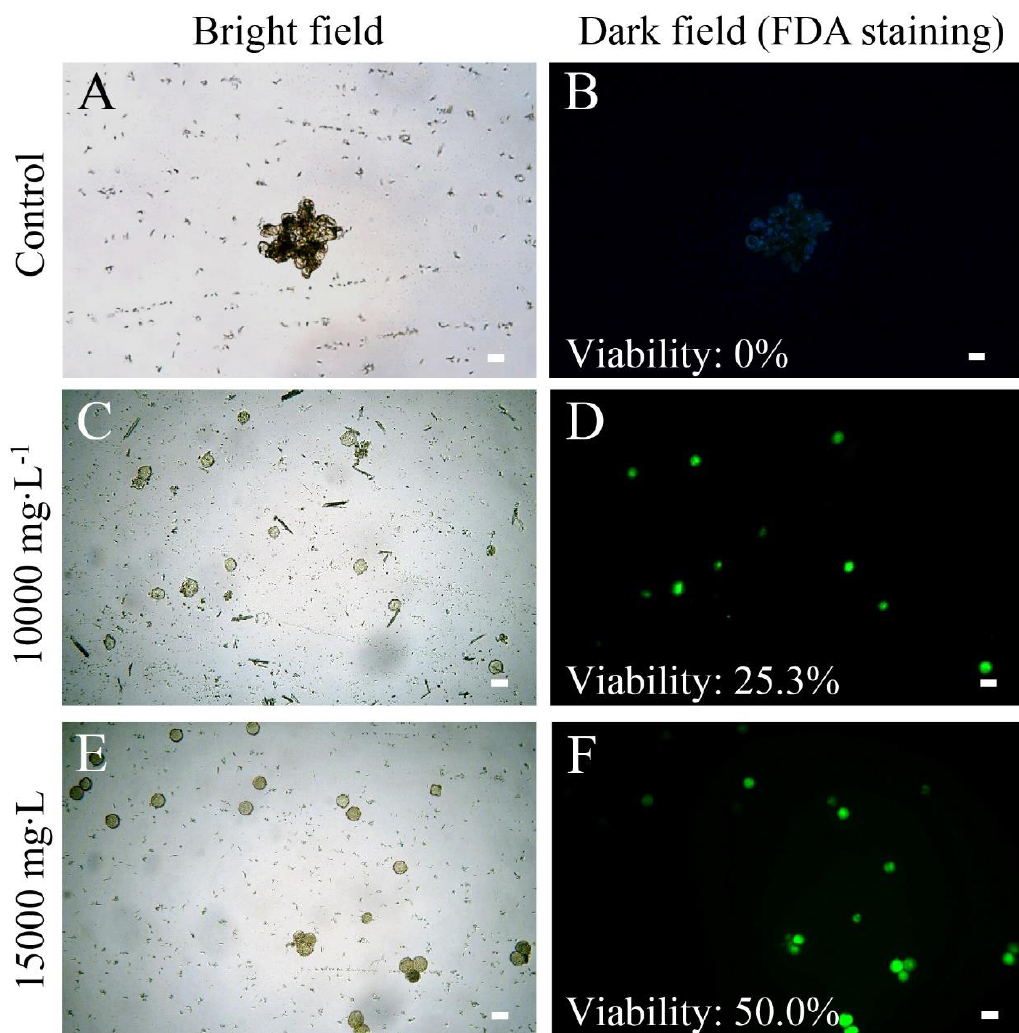
Figure 5. Pollen viability of ‘103-1’ ( Kalanchoe garambiensis ‘Type 1’ × K. nyikae ) was restored in colchicine-treated ’103-1’ clones using fluorescein diacetate (FDA) viability staining. ( A , B ), no colchicine control ‘103-1’ clone produced aggregated pollen with no observable viability. ( C , D ), a 10,000 mg∙L −1 colchicine-treated ‘103-1’ clone produced pollens with 25.3% of viability. ( E , F ), a 15,000 mg∙L −1 colchicine-treated ‘103-1’ clone produced pollens with 50.0% of viability. Scale bar = 20 μm.